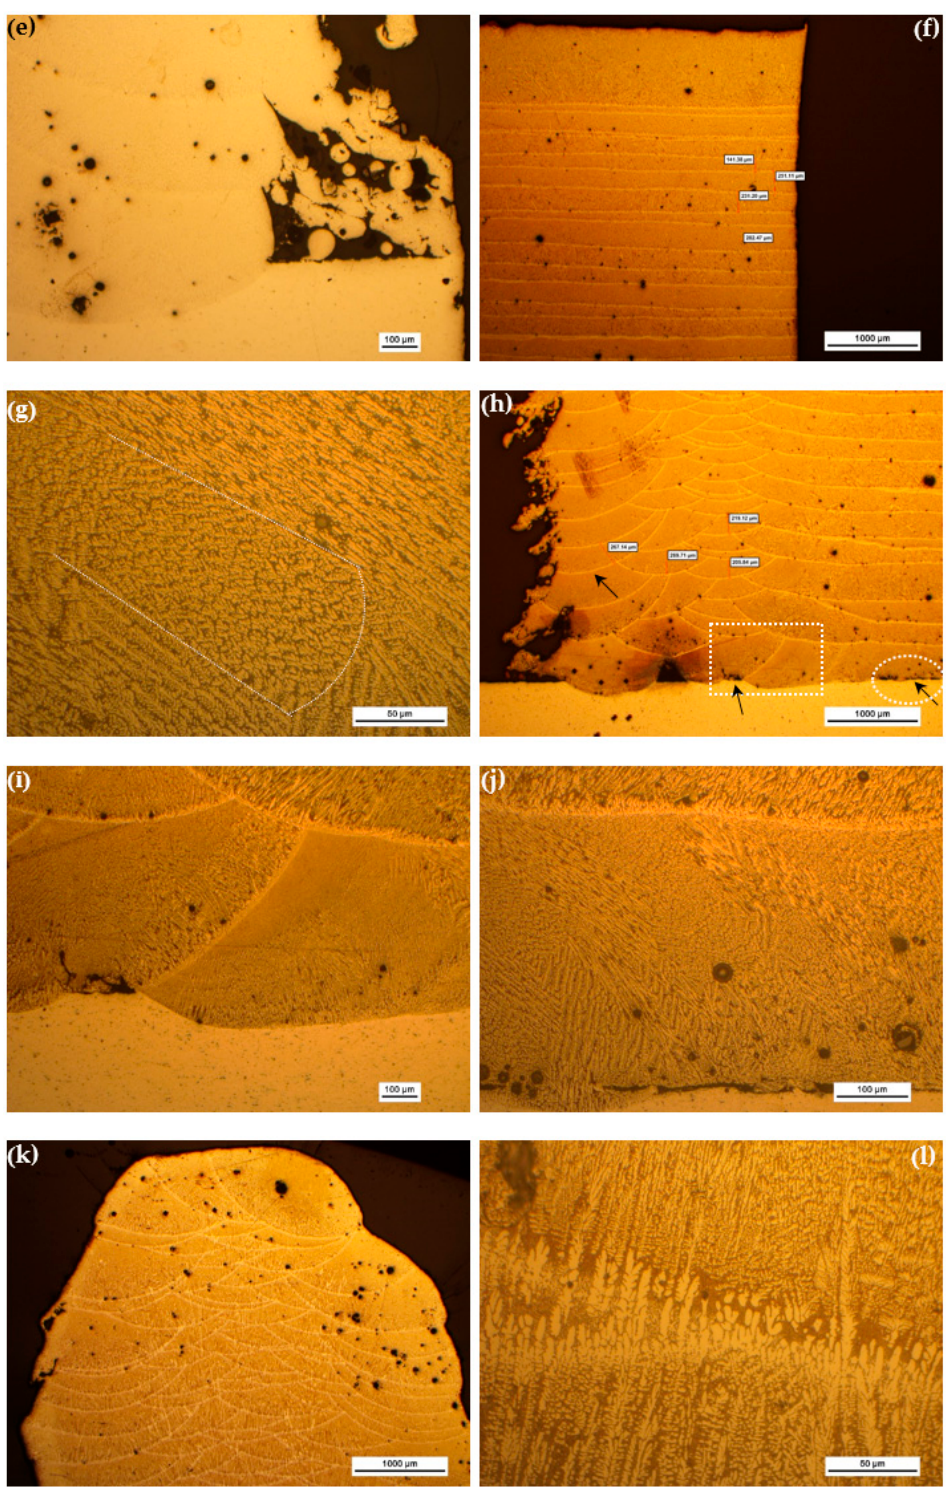
Figure 11. Microscopic characterization of the Al 4047 housing. ( a , b ) Stereomicroscope images revealing deposition layers, high surface roughness, and partially melted powder particles both on the outer wall ( a ) and the inner wall ( b ). These particles are accumulated preferentially at the interface between the substrate plate and the housing build. ( c ) Metallurgical cross-section in the A-A orientation marked in ( b ). ( d ) Metallurgical cross-section in the A-A orientation marked in ( b ). ( e ) Metallurgical